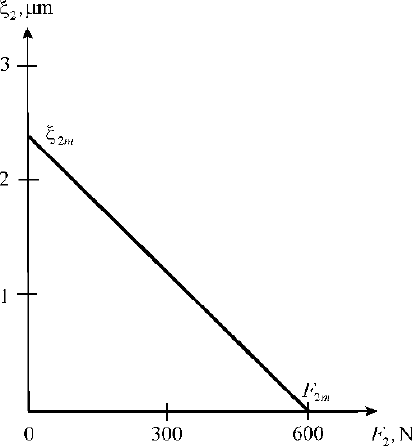
Figure 8. Static characteristic multilayer piezoactuator for longitudinal piezoeffect.